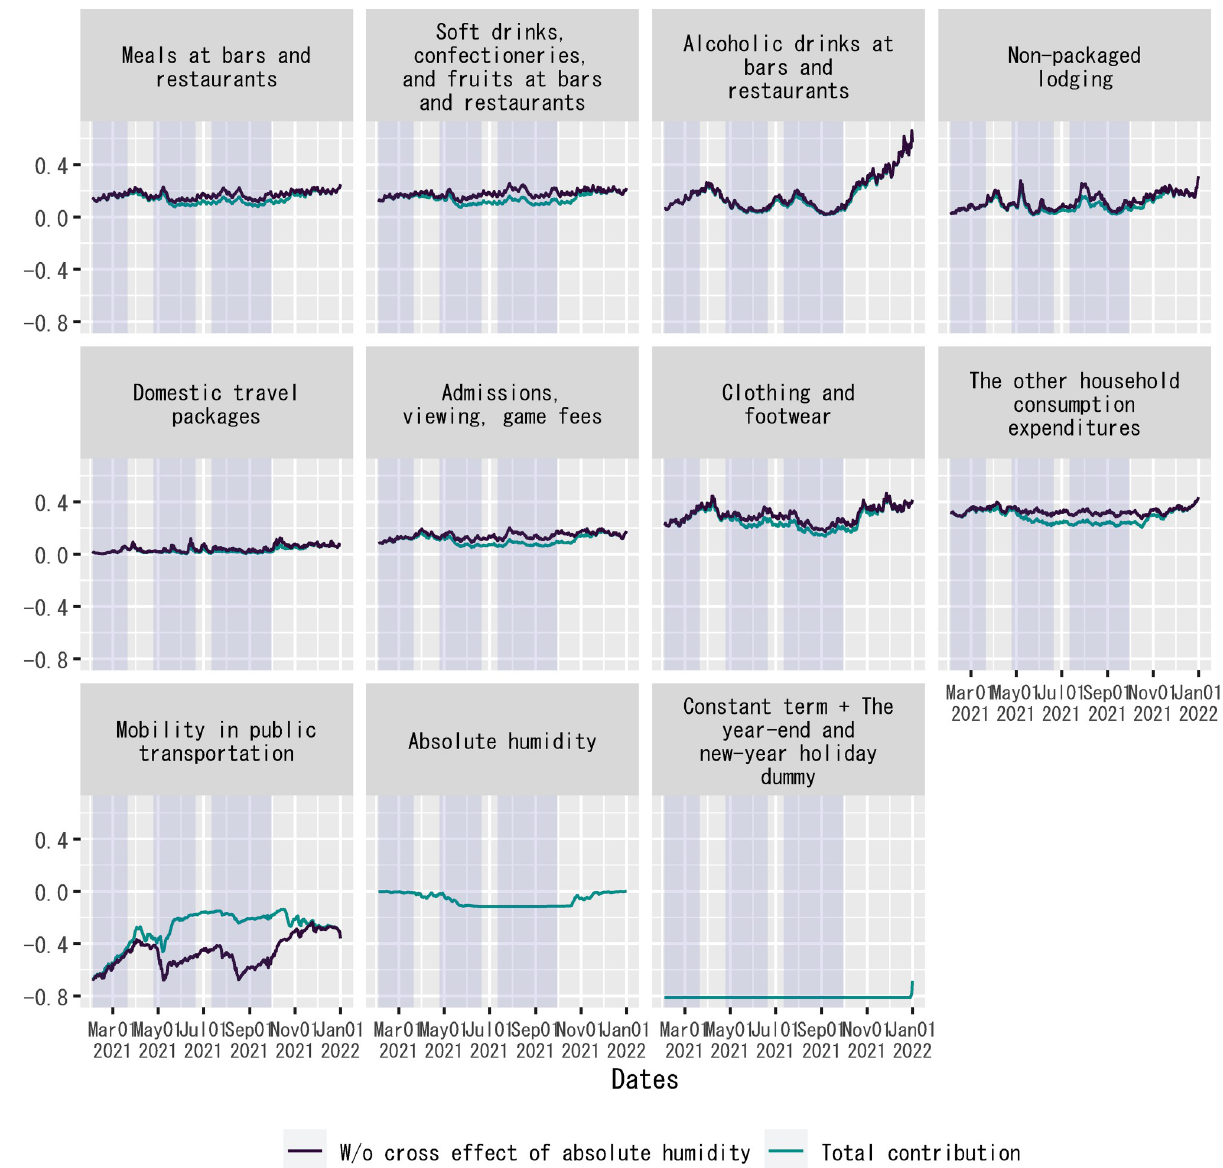
Fig 7. Decomposition of out-of-sample forecasts of the regression: Level. Each panel shows the product of an explanatory variable and the posterior mean of the corresponding regression coefficient. For out-of-sample forecasts, the time dummy for the second state of emergency is set to zero without changing the posterior means of regression coefficients. The sample period shown in the figure is from February 2, 2021, to January 1, 2022. For household expenditures and mobility in public transportation, “W/o cross effect of absolute humidity” indicates the posterior mean of γ j F ( X j , t ) in Eq (7), whereas “Total contribution” indicates the posterior mean of γ of emergency.